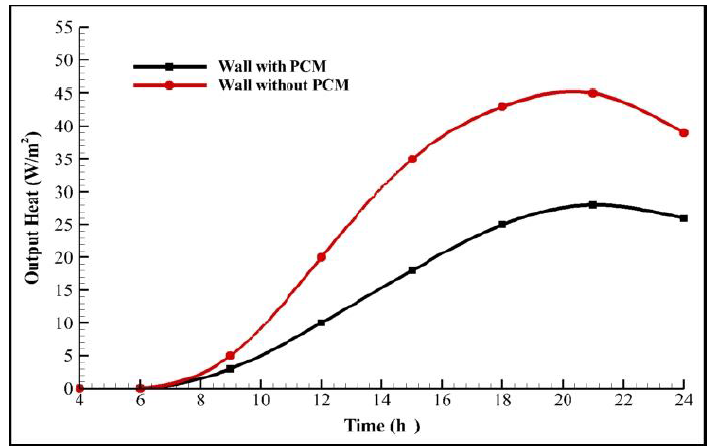
Figure 9. Heat flux through the internal surface of the non ‐ PCM ‐ and PCM ‐ treated east walls.